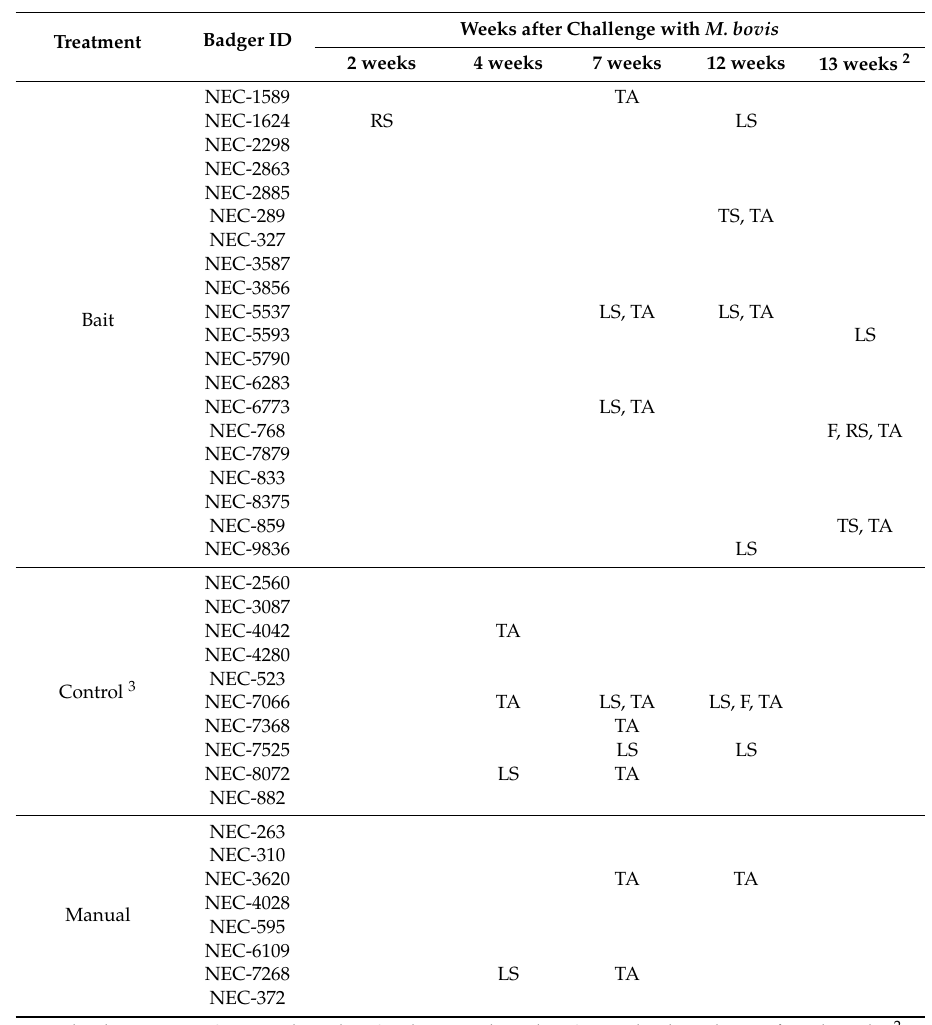
Table 9. Clinical samples from VES10 that yielded a positive M. bovis culture 1